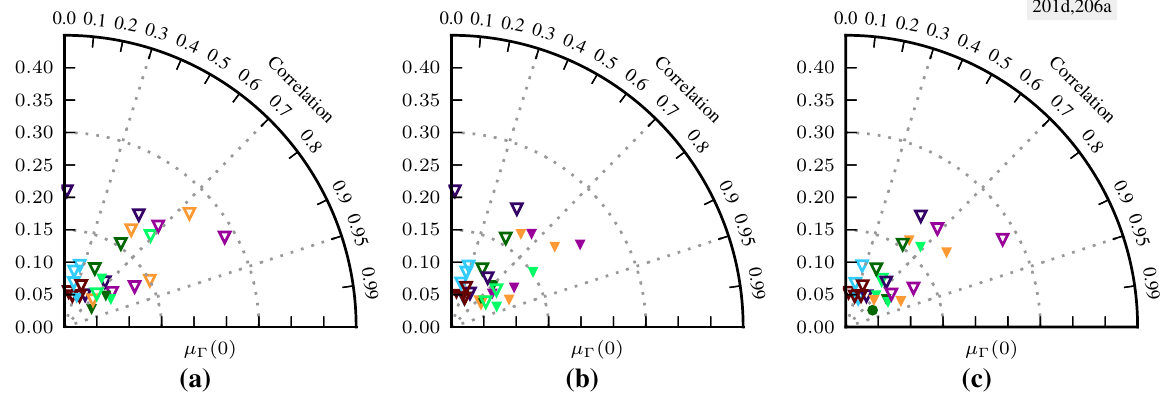
Figure 12. Taylor plots for bicoherence calibration based on VV phase triplets: ζ “ 0 ; cf. Figure 6 for a description of these plots. ( a ) Ξ A “ 1 ,